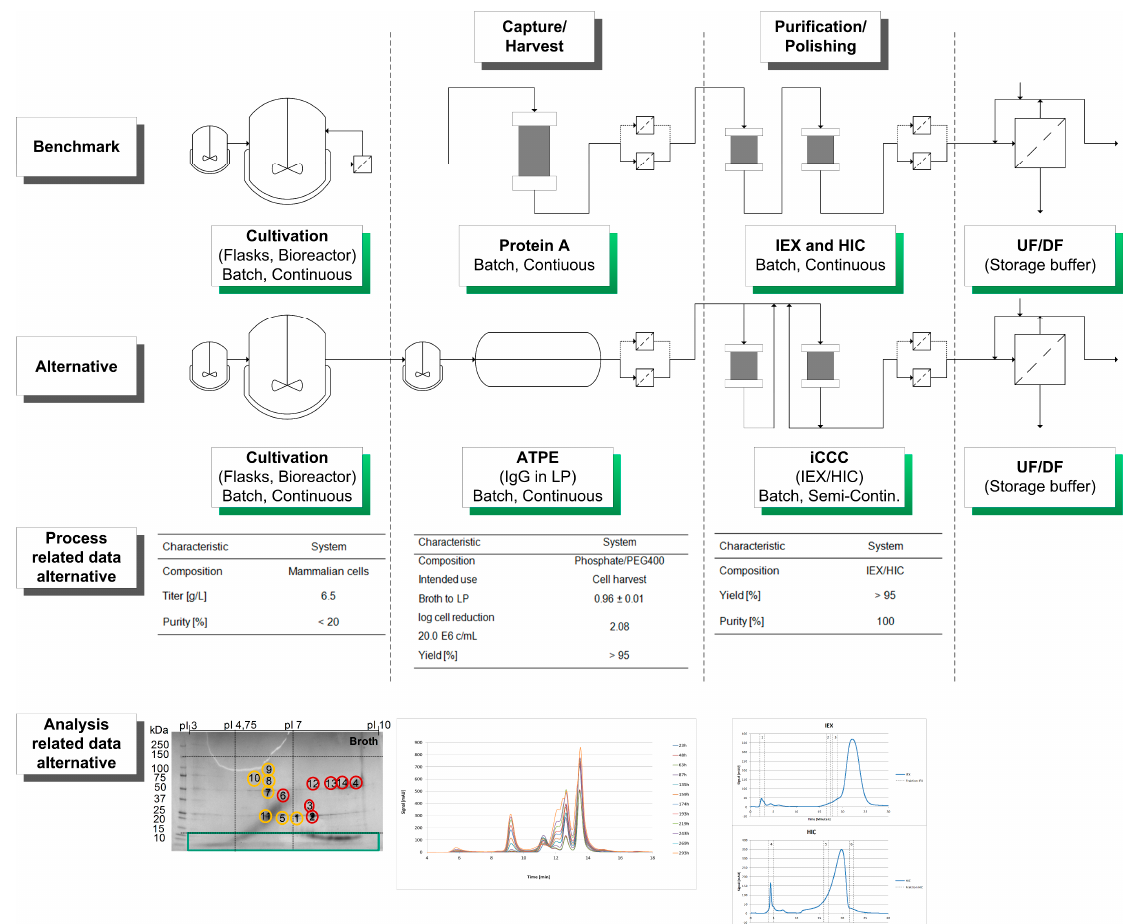
6 Figure 6. Schematic overview of the considered alternative process in comparison of the benchmark manufacturing route. In addition, process and analysis related data are shown and discussed in the